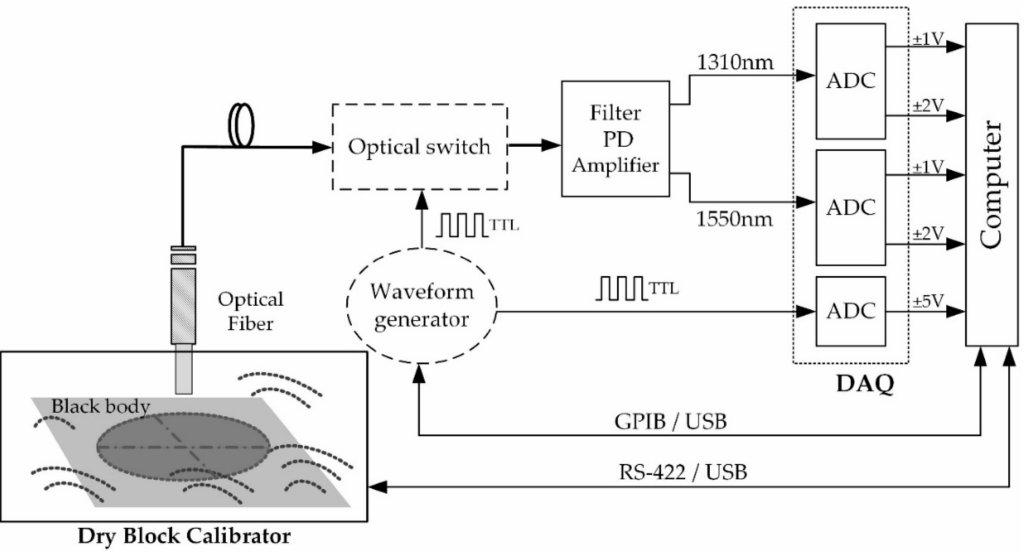
Figure 2. Schematic of the setup for the pyrometer calibration. Dashed lines are parts only included if the optical switch is considered. ADC: analog-to-digital